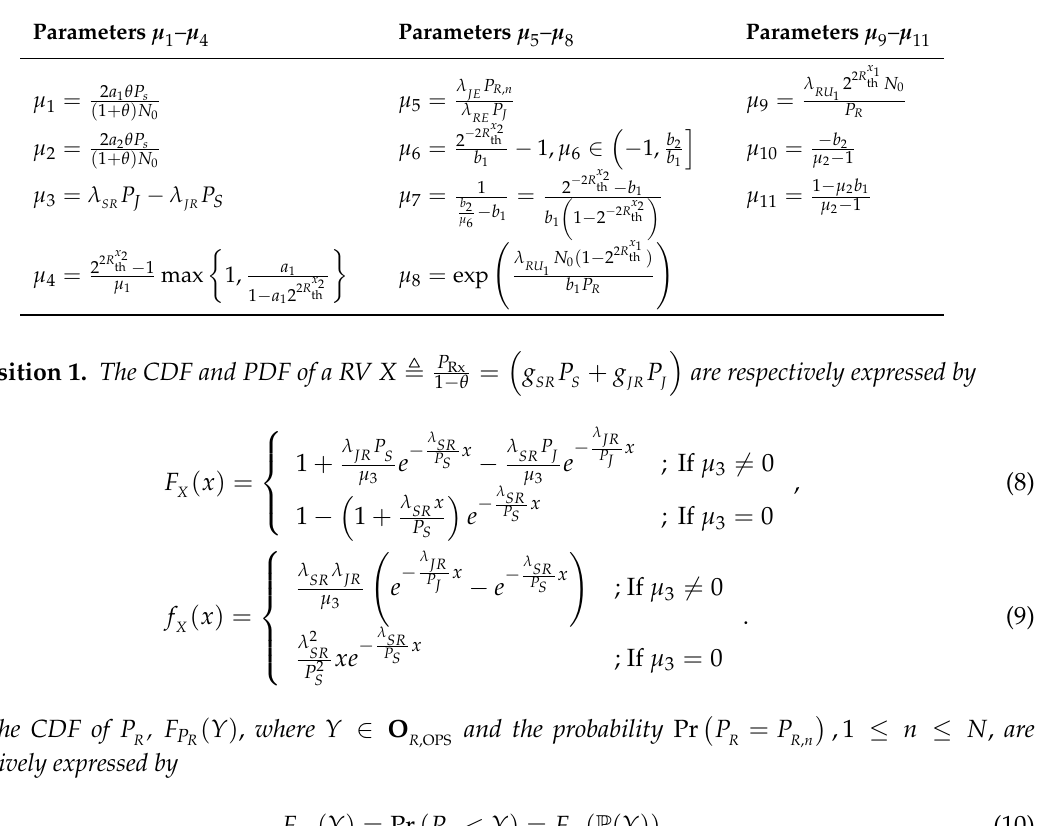
Table 1. The list of parameters µ k ,1 ≤ k ≤